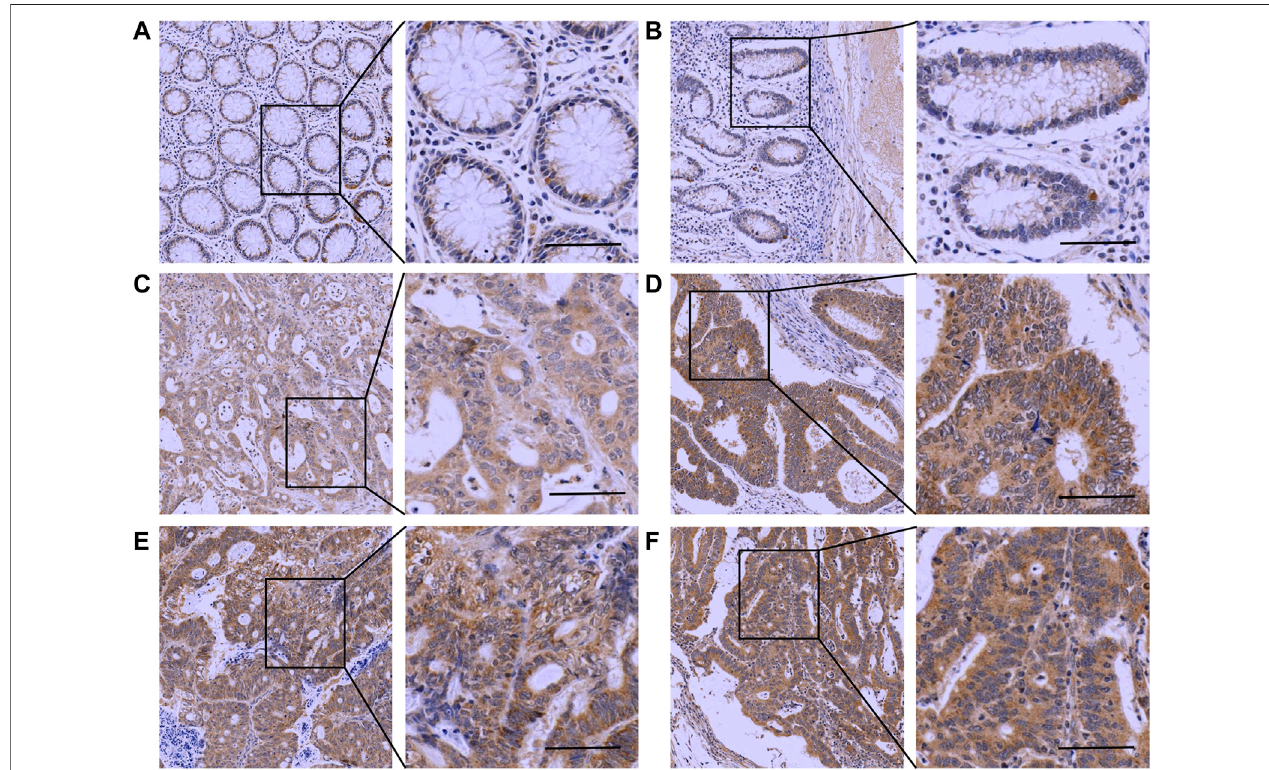
FIGURE 9 | Immunohistochemical analysis of Mapk14 expression in CRC tissues. (A, B) Mapk14 expression in normal tissues. (C) Mapk14 expression in CRC tumortissuesatstageI. (D) Mapk14expressioninCRCtumortissuesatstageII. (E) ExpressionofMapk14inCRCtumortissuesatstageIII. (F) ExpressionofMapk14in CRC tumor tissues at stage IV. (Left: SP × 200; Right: magni fi ed view).